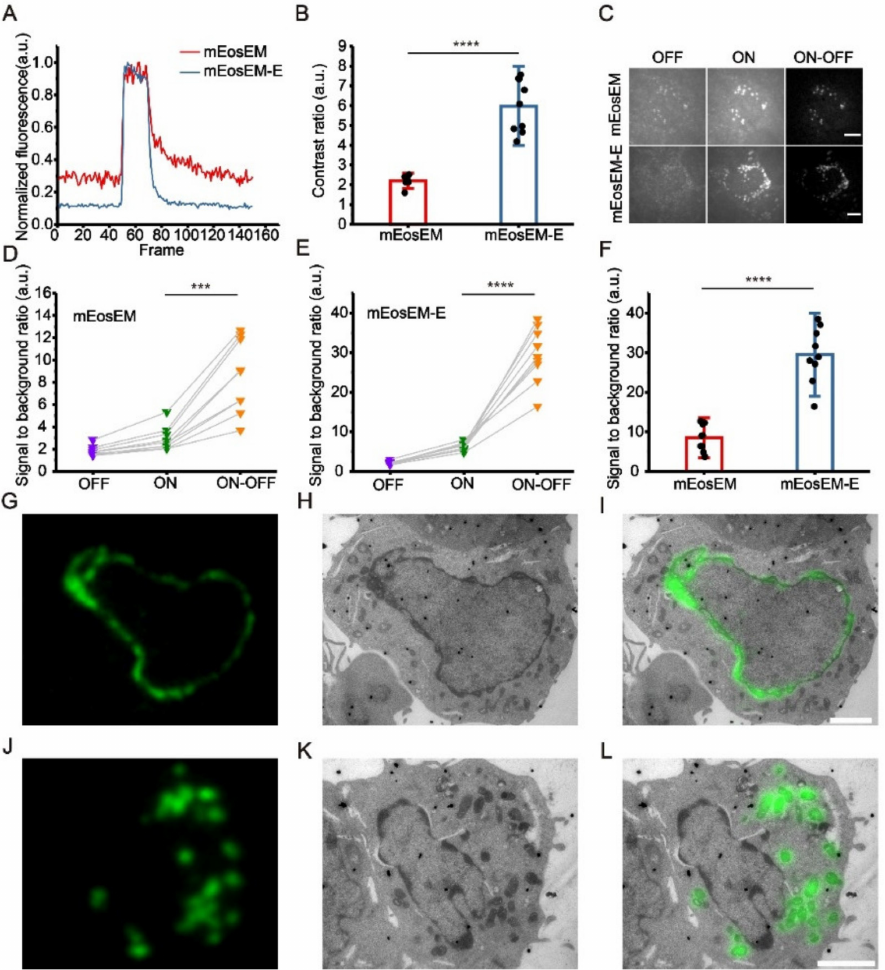
Figure 1. mEosEM-E is an improved green RSFP for high SBR sCLEM imaging. ( A ) Representative normalized photoswitching curves of Epon-embedded HEK 293T cell sections (100 nm) expressing mitochondria-targeted mEosEM (red) and mEosEM-E (blue). Samples were excited and switched off with the 488-nm laser (0.41 kW/cm 2 ) and switched on with the 405-nm (0.21 kW/cm 2 ) laser for 1 s. ( B ) Histogram of the photoswitching contrast ratio of mEosEM (red) and mEosEM-E (blue). Data are summarized in Table S2. Bars represent mean ± SD. p values were determined with two-tailed t -test ( n = 9). **** indicates p < 0.0001. ( C ) Representative OFF (left), ON (middle), and ON-OFF (right) images of Epon-embedded HEK 293T cell sections (100 nm) expressing mitochondria-targeted mEosEM and mEosEM-E. Scale bar, 5 µ m. ( D , E ) SBR of mEosEM- ( D ) and mEosEM-E- ( E ) labelled cell samples in OFF (purple), ON (green), and ON-OFF (orange) images. Data are summarized in Tables S3 and S4. p values were determined with two-tailed t -tests ( n = 9). *** indicates p < 0.001, **** indicates p < 0.0001. ( F ) Statistics SBR of mEosEM (red) and mEosEM-E (blue) in ON-OFF images. Two-tailed t -tests were performed ( n = 9). **** indicates p < 0.0001. Data are summarized in Table S5. ( G – L ) Post-Epon-embedding CLEM of mEosEM-E. FM, EM, and CLEM images of nuclear envelope ( G – I ) and mitochondria ( J – L ) labelled by mEosEM-E (100 nm slices). Scale bars, 2 µ